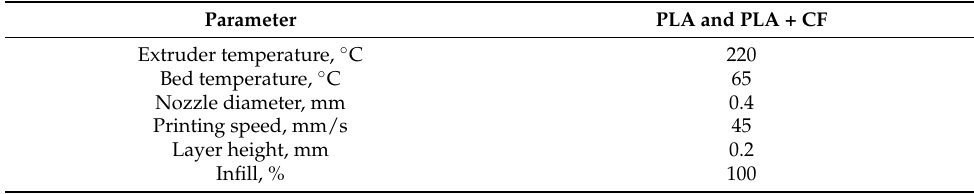
Table 4. FDM Printing